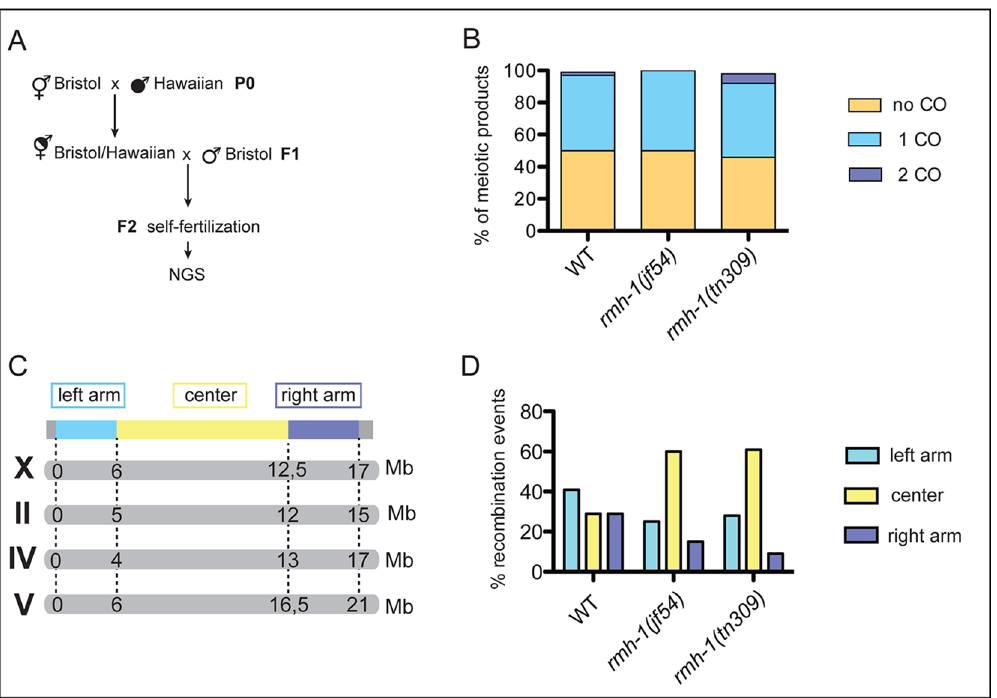
Fig 8. RMH-1 promotes the bias for CO formation on chromosome arms. (A) Schematics of crosses to obtain the progeny of singled F2 individuals subjected to Next Generation Sequencing (NGS) for SNP analysis. White insert indicates the WT (Bristol) background, and black insert indicates the Hawaiian background. (B) Quantification of the overall recombination frequencies for assayed chromosomes; stacked bar graph indicates the fraction of meiotic products with zero, one, or two COs. For WT ( n = 36 chromatids), for rmh-1(jf54) ( n = 40 chromatids), and for rmh-1(tn309) ( n = 45 chromatids). The frequency of COs was not found to be different between WT and both mutants (Chi 2 test). (C) Scheme of the different chromosomes used during the recombination assay. The chromosome domains (left arm in blue, center in yellow, and right arm in purple) are correlated with the physical map of each chromosome. (D) Locations of the recombination events (assayed for chromosomes X, IV, and V) in WT ( n = 17 COs: three events on X, four on II, four on IV, and six on V), for rmh-1(jf54) ( n = 20 COs: 11 events on II and 9 on V), and rmh-1(tn309) ( n = 21 COs: nine events on X, nine on IV, and three on V); also see the Experimental Procedures section. The relative distribution of COs in the center versus arm domains differed from the WT for tn309 ( p = 0.046, Chi 2 test) and for jf54 , (p = 0.062, Chi 2